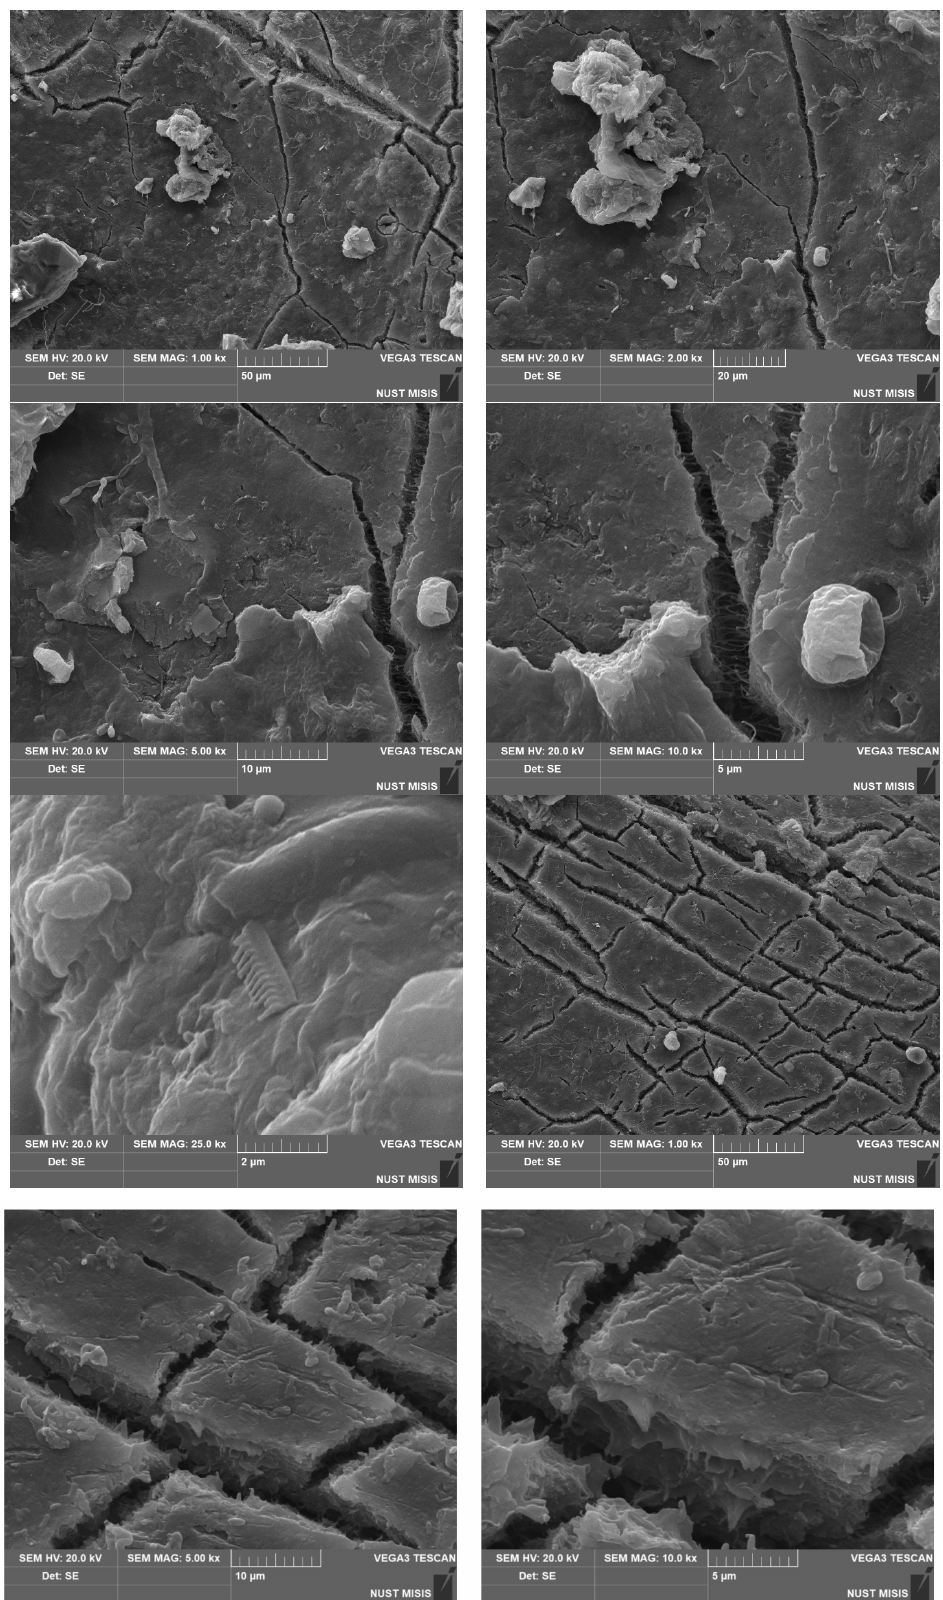
Figure 12. SEM images of the PLA/PBAT film surface after composting for 365